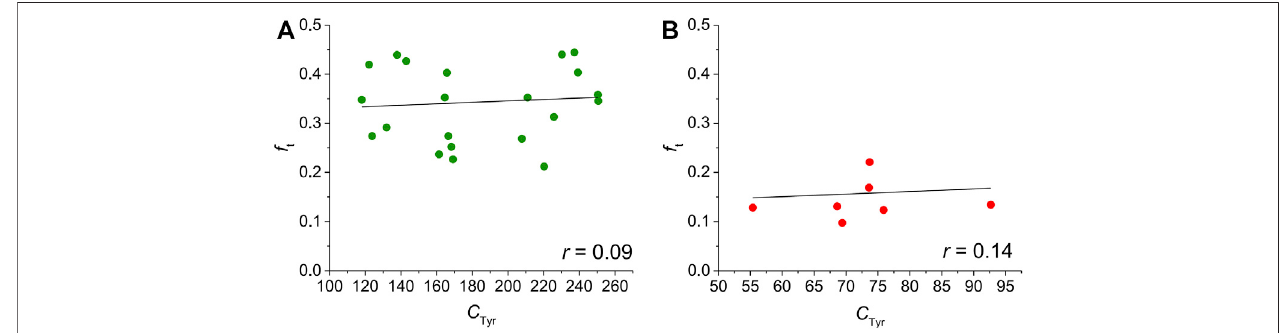
FIGURE 4 | Correlation between f t and C Tyr in ventricular (A) and atrial (B) rat cardiomyocytes. No correlation can be observed in our data ( p > 0.05 in both ventricular and atrial myocytes).